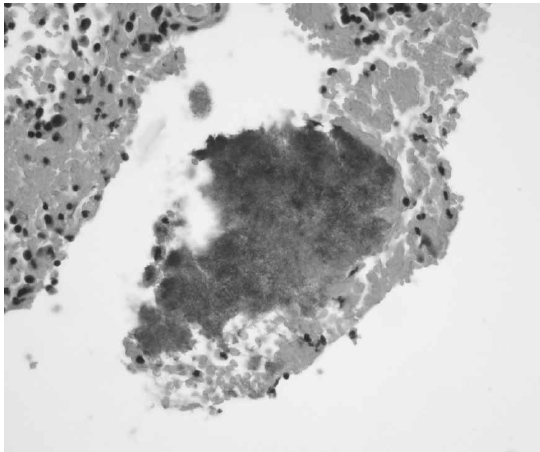
Figure 1. ‘‘Sulfur granule’’. Hematoxylin and eosin (H&E) stain illustrating a microscopic abscess of tangled actinomyces sur- rounded by neutrophils (magnification 6 200).